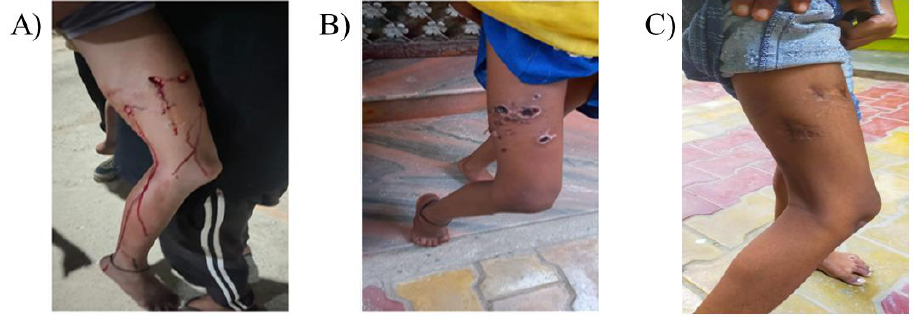
Figure 3. ( A ) Multiple deep wounds with profuse bleeding dated 20 February 2022, on girl’s right thigh after bite from the suspected rabid dog, ( B ) Wound in healing stage dated 3 March 2022, after timely, adequate, and appropriate anti-rabies management initiated, and ( C ) wound completely healed (dated 25 August 2022).